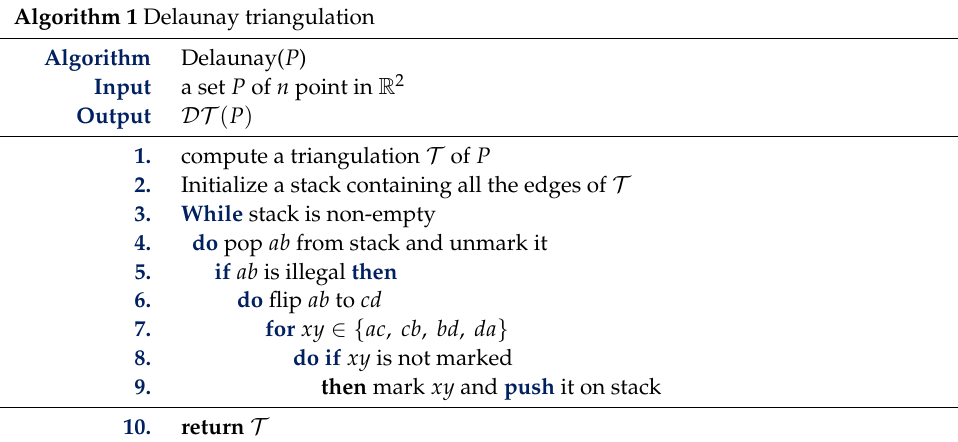
Algorithm 2 Delaunay’s edge counting algorithm . Algorithm